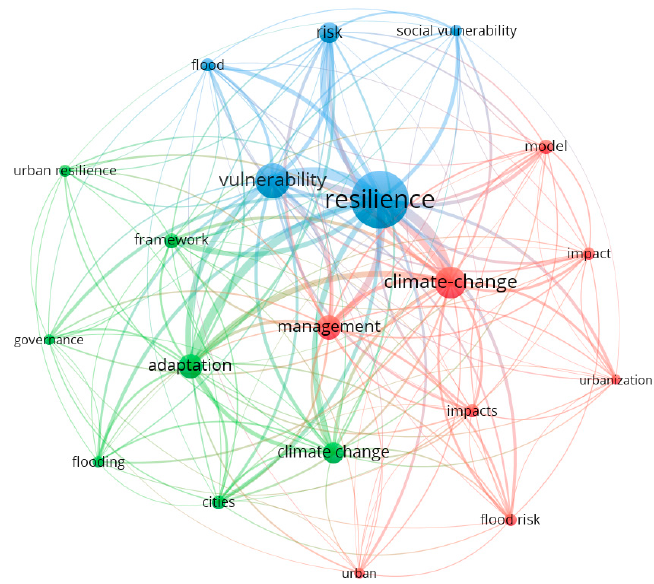
Figure 2. Keyword view in domestic urban flood-resilience-related literature from 1999 to 2021.